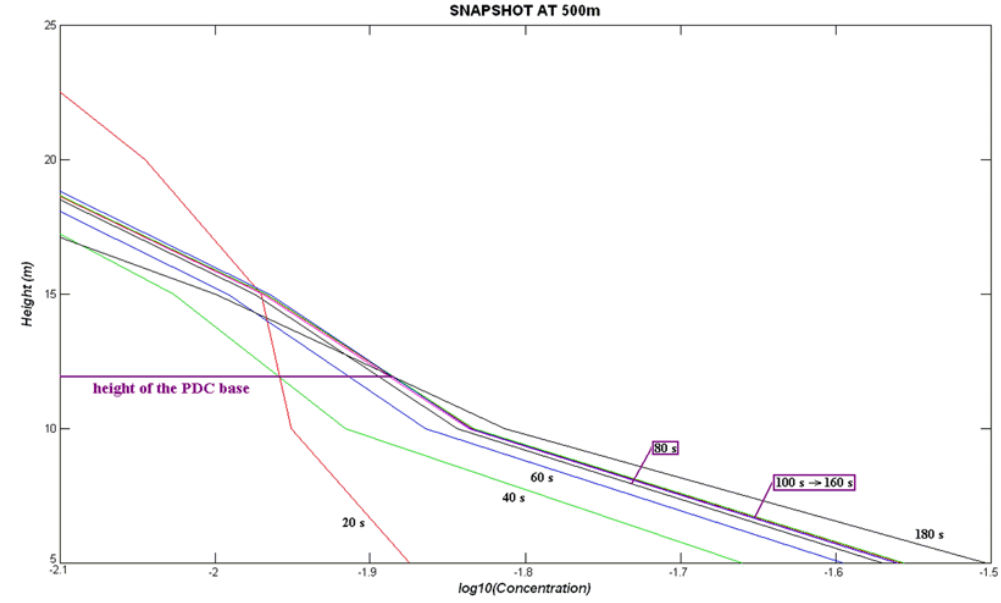
Fig. 4b. Zoom of Fig. 4 illustrating the solid particle concentration at the base of the PDC.